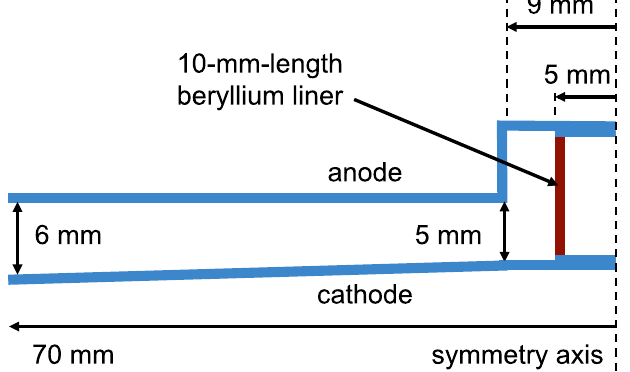
FIG. 6. Idealized representation of the inner MITL coupled to a MagLIF load.